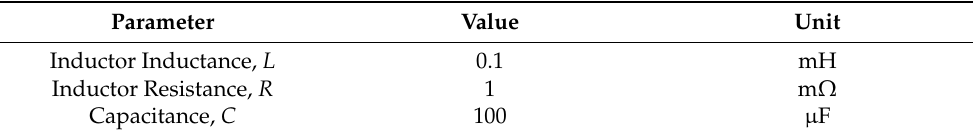
Table 1. Parameters of the simulated DC–DC buck-boost converter.